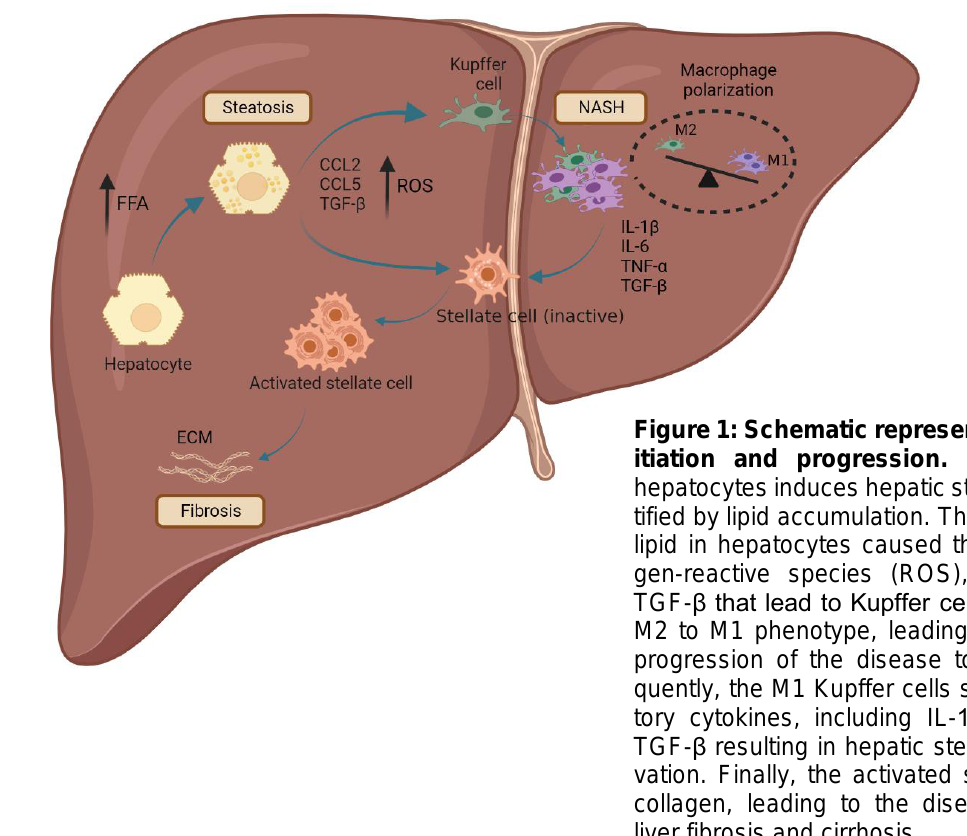
Figure 1: Schematic representation of NAFLD in- itiation and progression. Lipid overloading in hepatocytes induces hepatic steatosis which is iden- tified by lipid accumulation. The accumulation of the lipid in hepatocytes caused the generation of oxy- gen-reactive species (ROS), CCL2, CCL5, and TGF-β that lead to Kupffer cell transformation from M2 to M1 phenotype, leading to inflammation and progression of the disease to the NASH. Conse- quently, the M1 Kupffer cells secrete pro-inflamma- tory cytokines, including IL-1β, IL-6, TNF-α, and TGF-β resulting in hepatic stellate cell (HSCs) acti- vation. Finally, the activated stellate cells produce collagen, leading to the disease's progression to liver fibrosis and